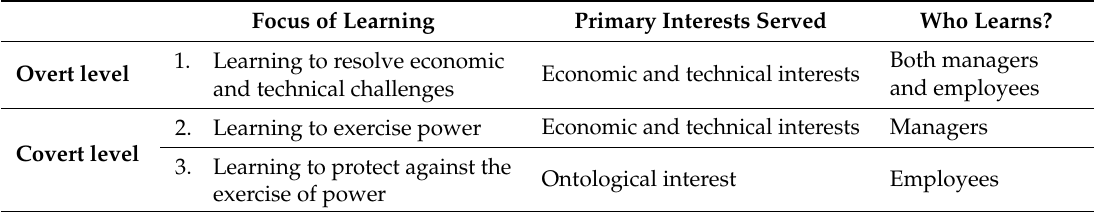
Table 1. A model of the relationship between shared learning and